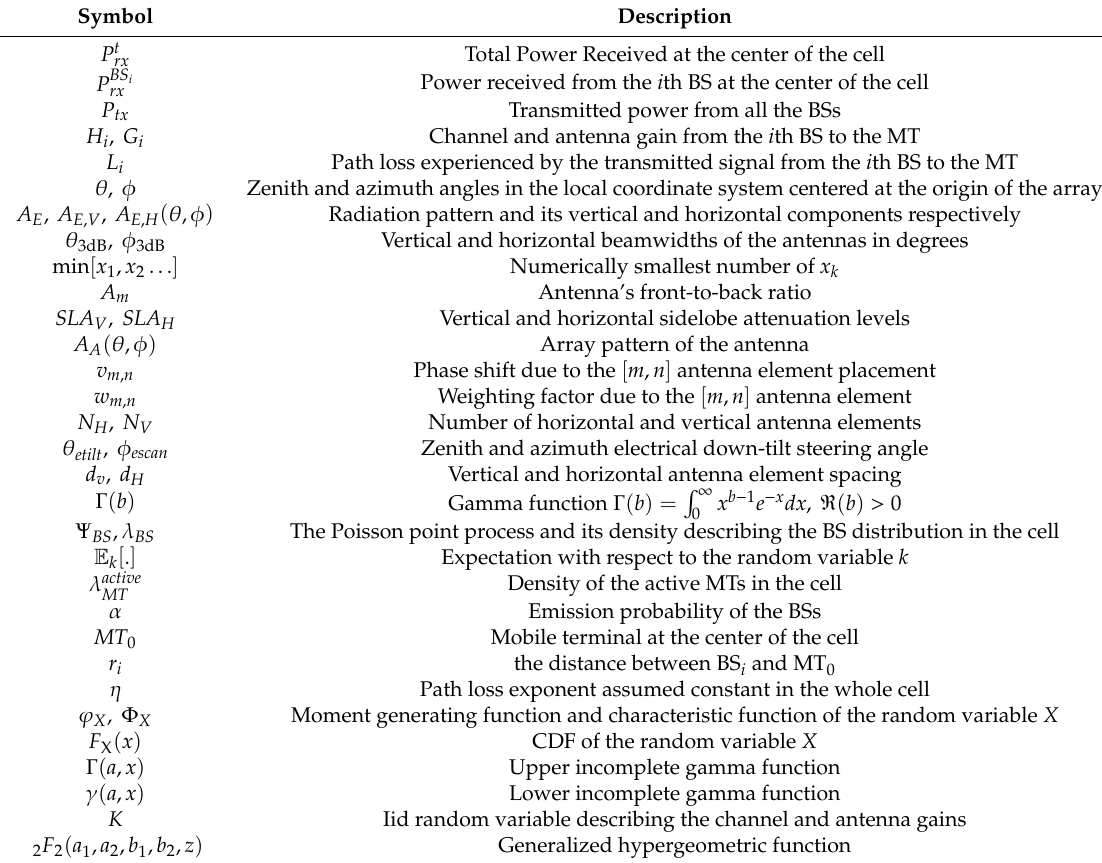
Table 1. List of symbols used in antenna pattern and model